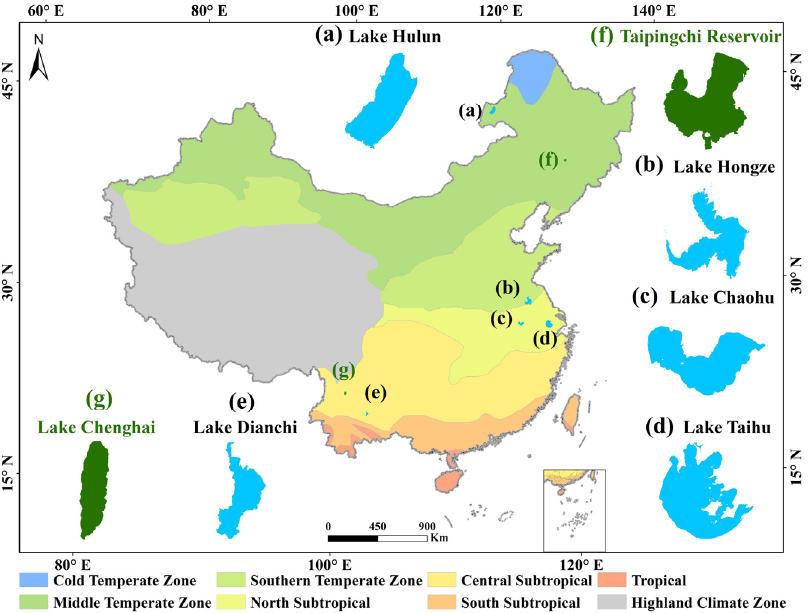
Figure 1. Locations and morphology of lakes and corresponding climatic zones. The blue lakes are the five lakes used for modeling and the green ones represent the two lakes used for method validation.